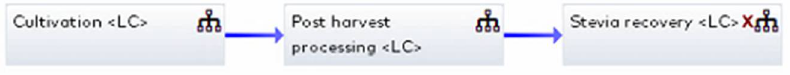
Figure 1. Overall plan for stevia powder production.